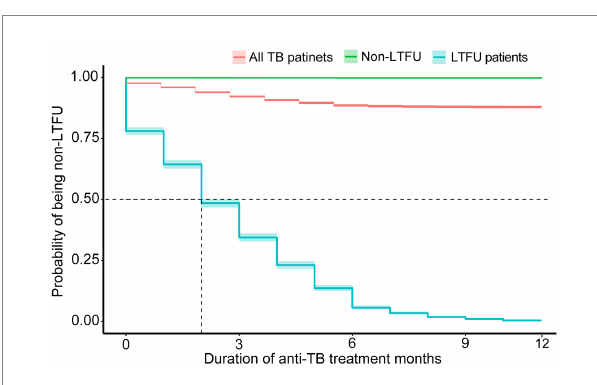
FIGURE 3 Time to loss to follow-up after diagnosing TB, using Kaplan–Meier analysis ( n = 24,265).